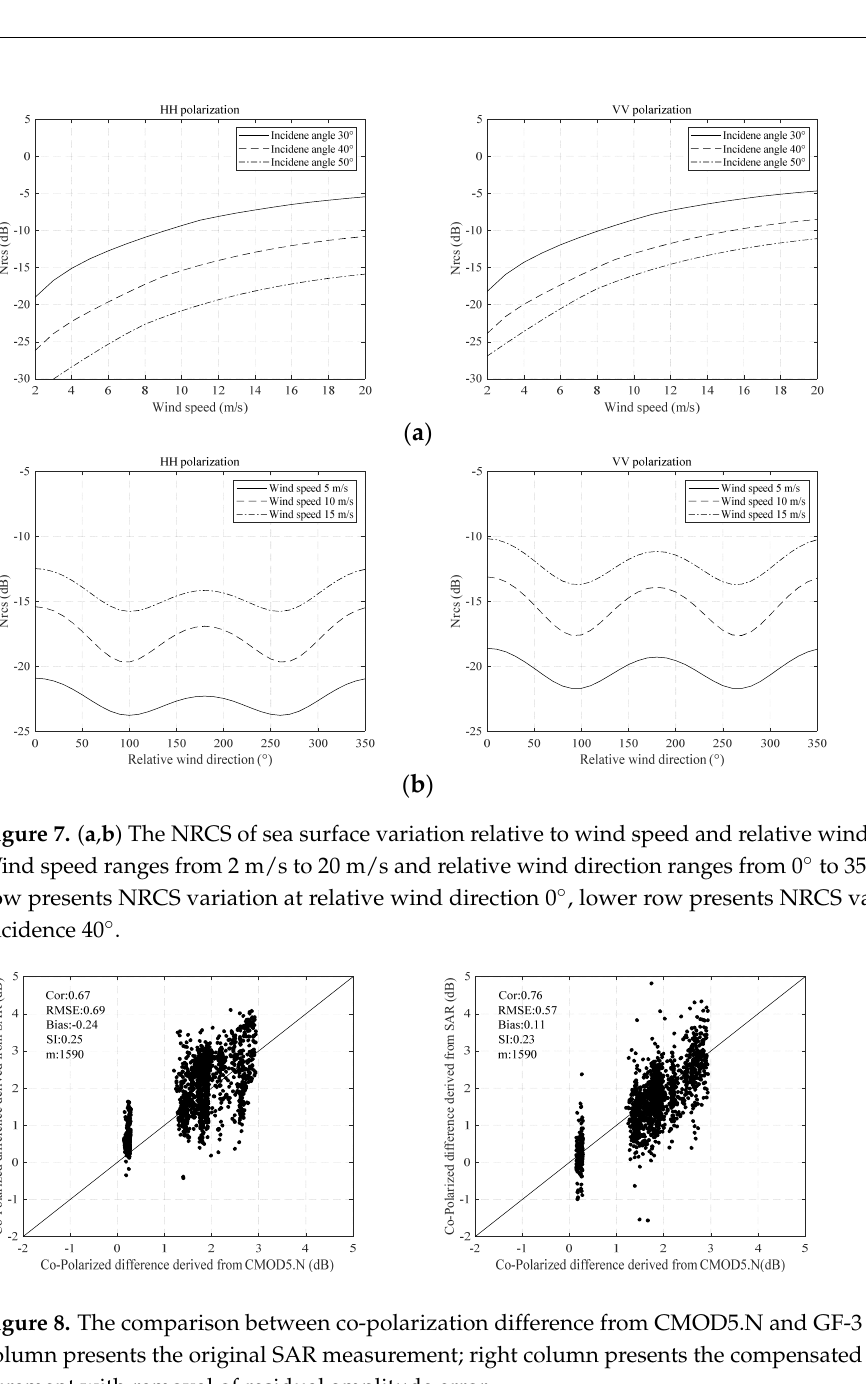
Figure 8. The comparison between co-polarization difference from CMOD5.N and GF-3 SAR. Left column presents the original SAR measurement; right column presents the compensated SAR meas- urement with removal of residual amplitude error.